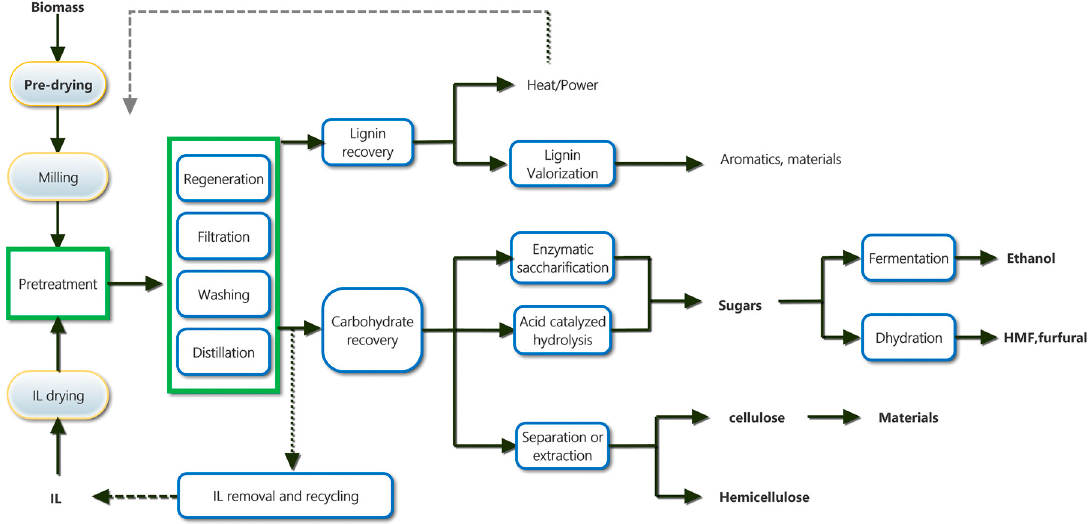
Figure 1. Typical routes for the pretreatment of lignocellulosic biomass with ILs.